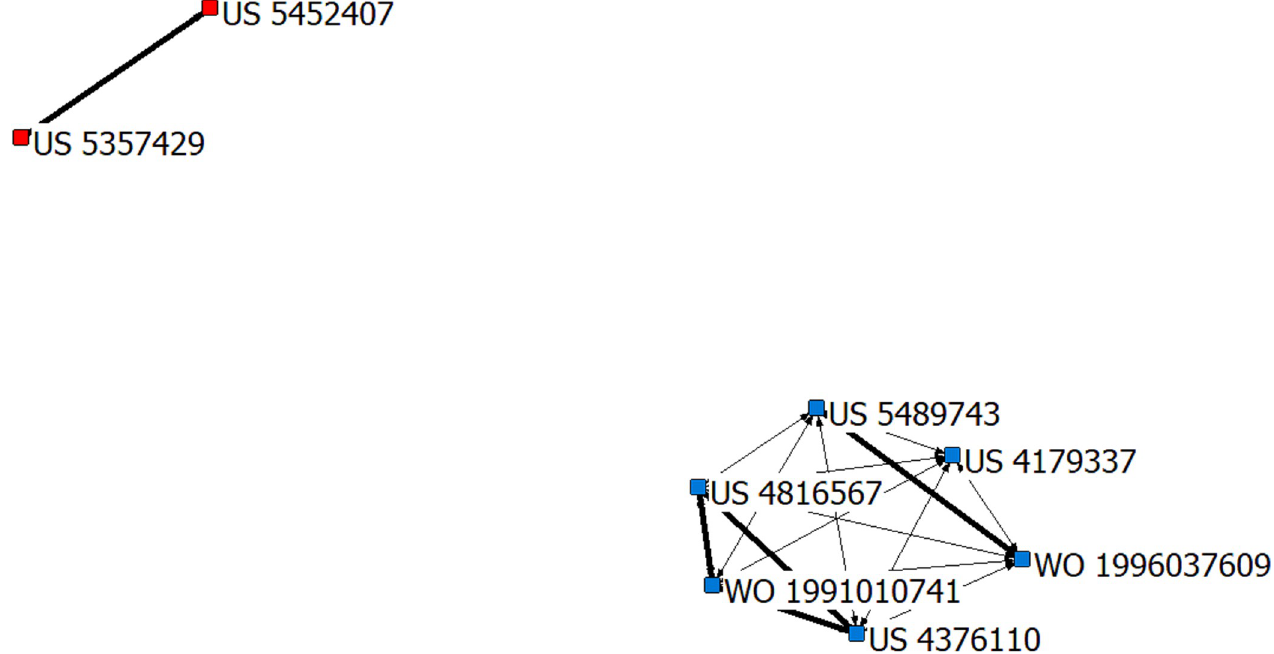
Fig 3. The patent co-citation network of the field of AI-assisted pathology from 1992 to 2000. Note: The subnetwork 1 is with the red nodes, and the subnetwork 2 with the blue nodes.